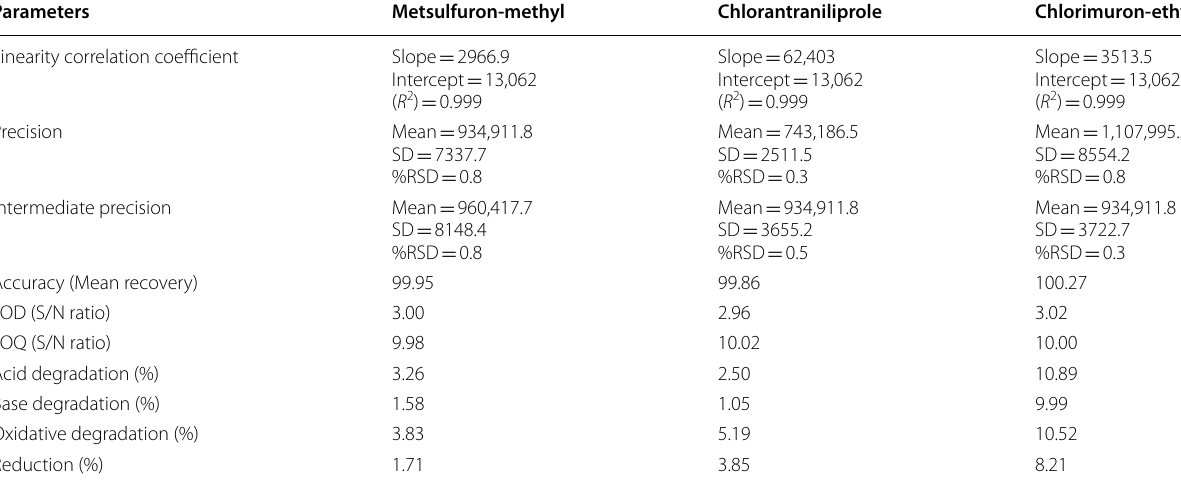
Table 5 Validation and stability parameters of the chemometrics optimized RP-HPLC method Parameters